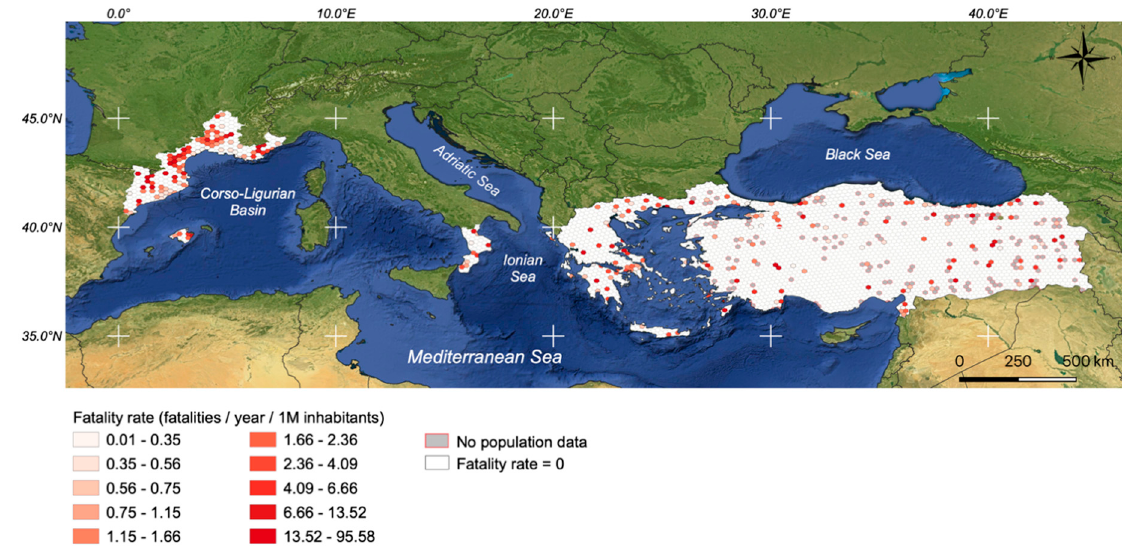
Figure 7. Fatality rate by 20 × 20 km hex grid cell based on the quantile classification excluding 0.00 values.